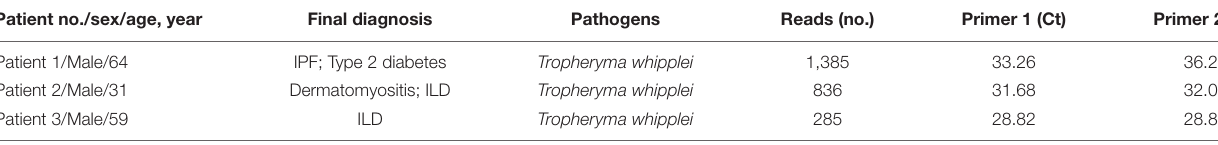
TABLE 1 | Summary of metagenomic sequencing and qPCR results of patients.